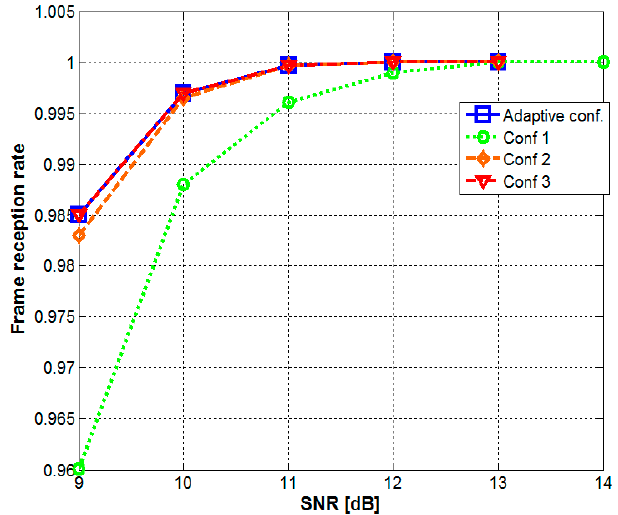
Figure 4. Frame delivery ratio for non-adaptive and SNR-adaptive configurations.